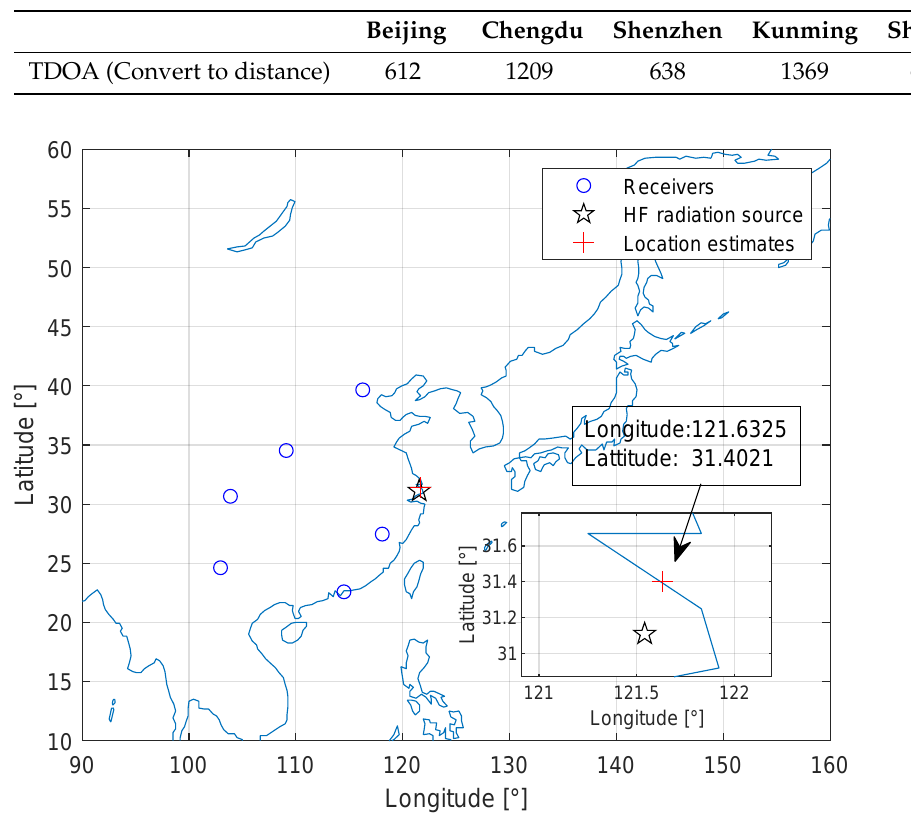
Figure 10. Received FSK signals with the center frequency of 8.433 MHz. Table 5. TDE results of FSK I/Q data (km).